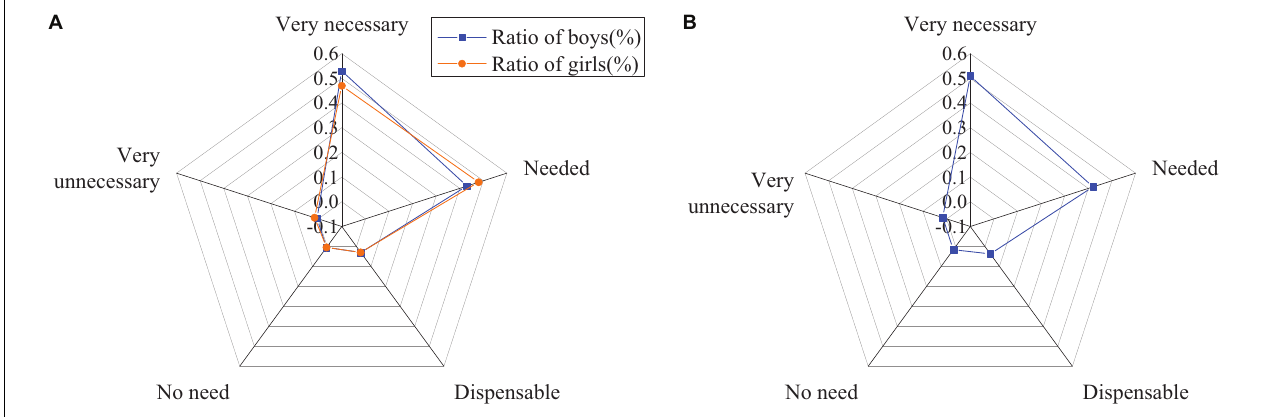
FIGURE 12 | Necessity of learning psychological knowledge [ (A) the ratio of men and women; (B) the ratio of all].